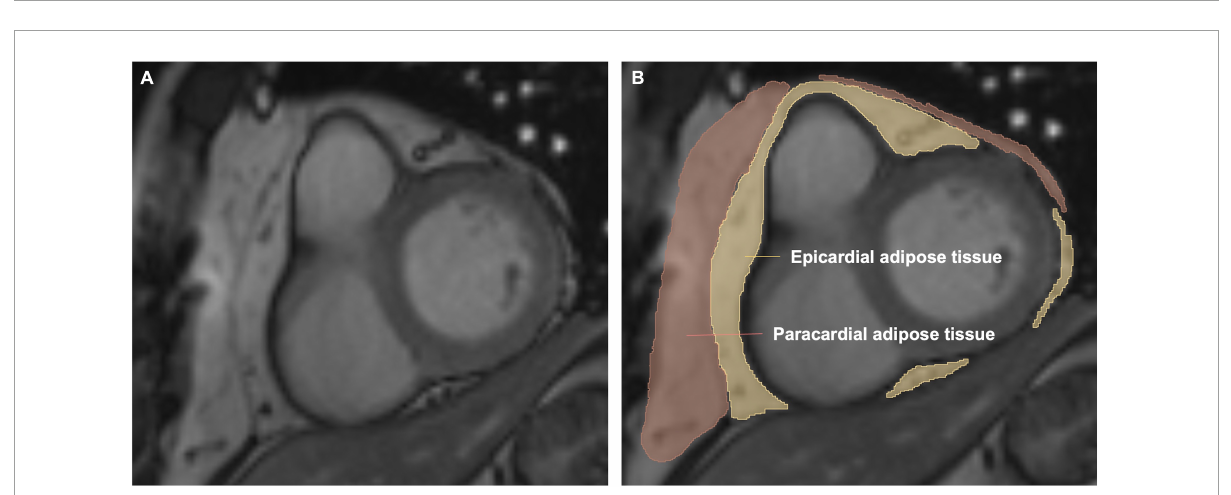
FIGURE2 Volumetric assessment of the epicardial adipose tissue (EAT) on short-axis slices. Panels (A,B) are representative images of one short-axis slice. Epicardial adipose tissue is shown in yellow. Paracardial adipose tissue is shown in red. Pericardial adipose tissue is epicardial adipose tissue plus paracardial adipose tissue. The EAT volume was calculated by summation of the results of each slice’s area multiplied by the slice thickness based on the modified Simpson’s rule.